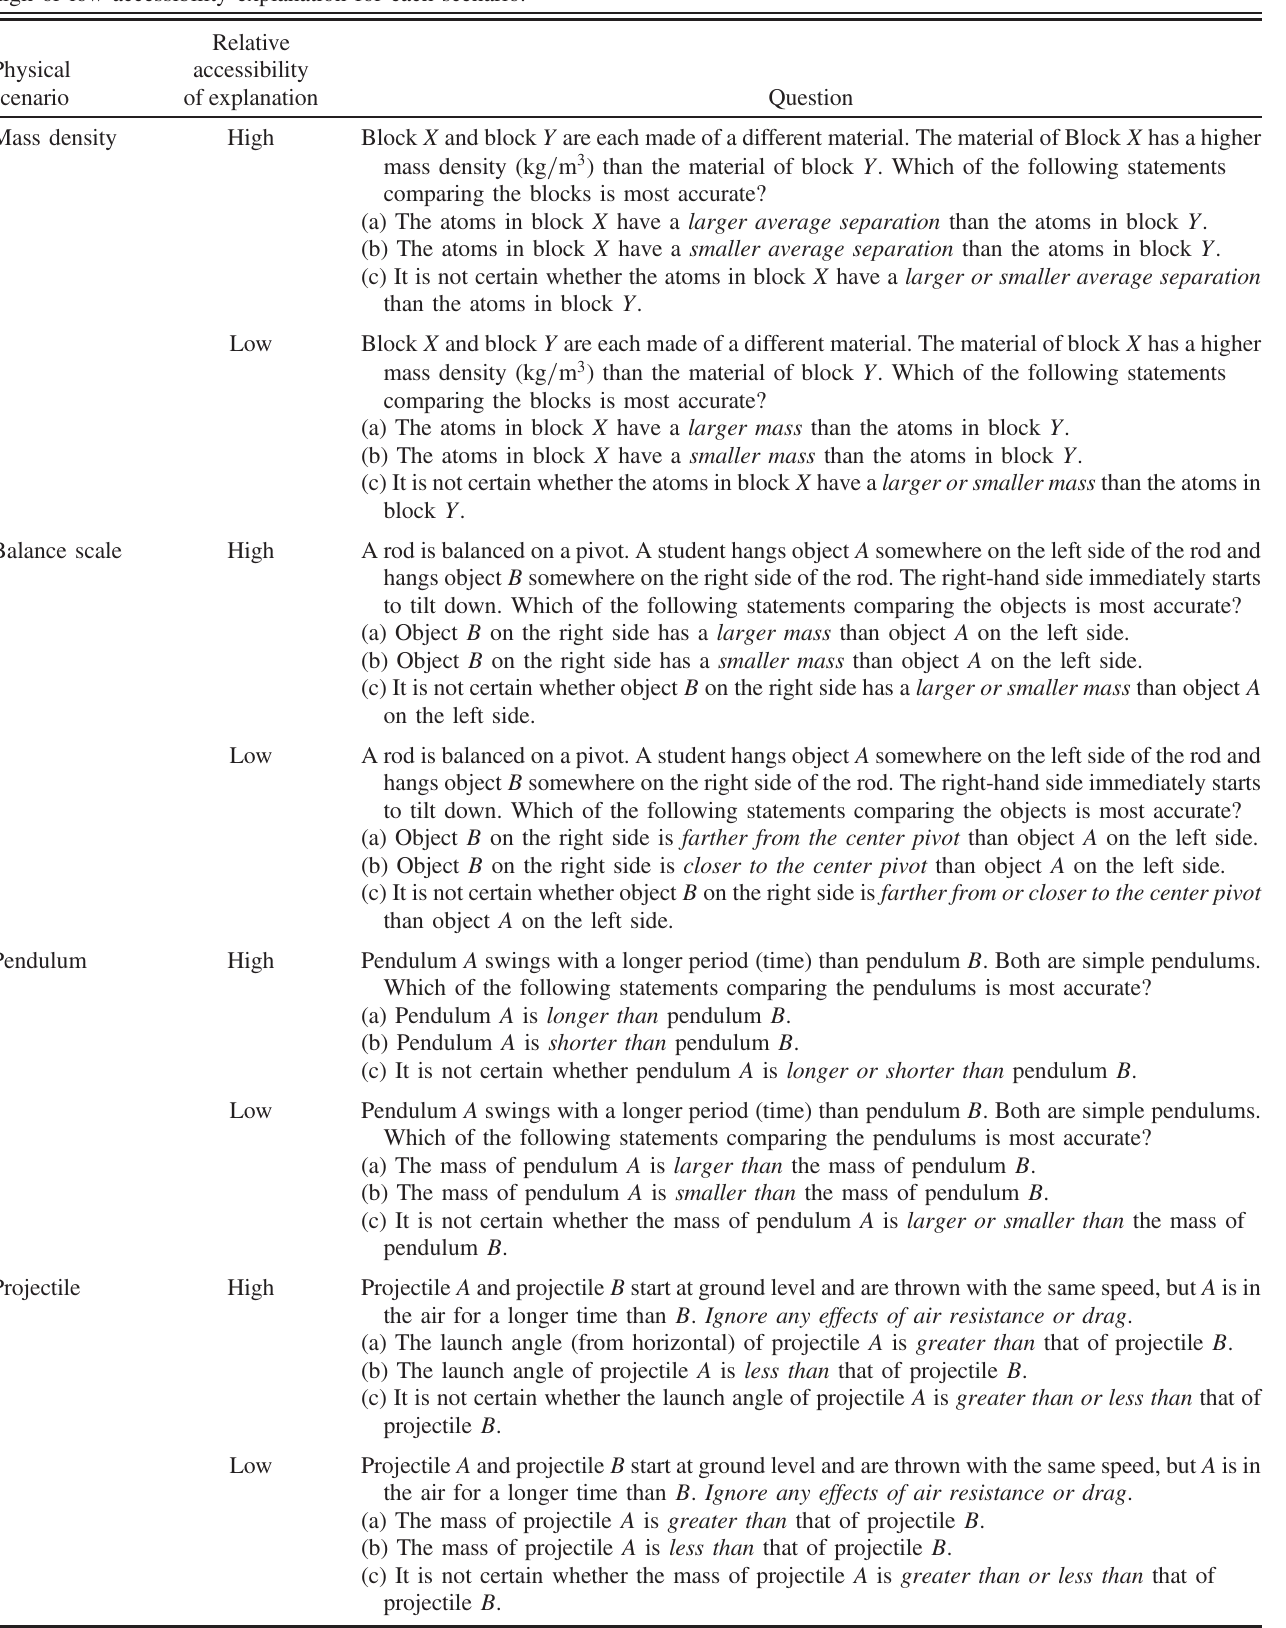
TABLE XV. Experiment 2 and Experiment 3 multiple-choice (diagnostic) answer format questions. Participants answered either a high or low accessibility explanation for each